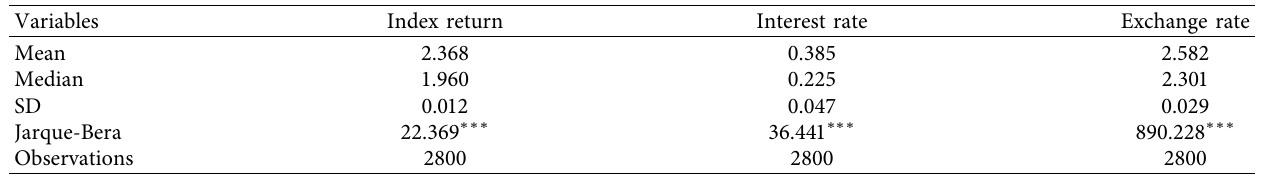
Table 4: Descriptive statistics for Hong Kong.